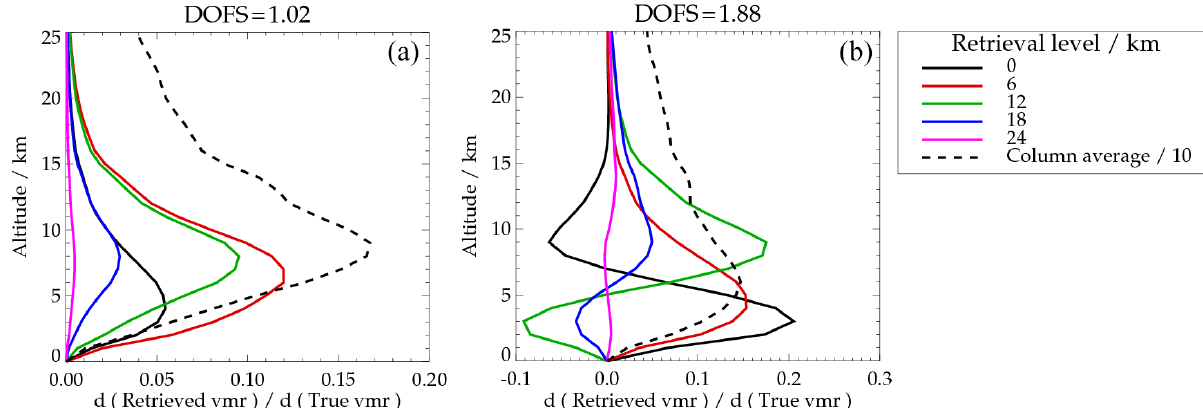
Figure 1. Averaging kernels for the methane profile at each retrieval level (solid) and for the column average (dashed). Panel (a) shows the result for NEBT = 0.5K, and panel (b) for NEBT = 0.1K. DOFS (the trace of the profile averaging kernel matrix) for each case is indicated above the panel. The averaging kernel for the column-averaged mixing ratio is also shown by the dashed line. This kernel is normalised so that it shows the derivative of the column-averaged mixing ratio with respect to perturbation in methane in fine layers, as a function of altitude (for an ideal retrieval this function should be 1, independent of altitude). Values of the column-averaged kernel shown here are divided by 10 to fit on the same scale as those for retrieval levels.